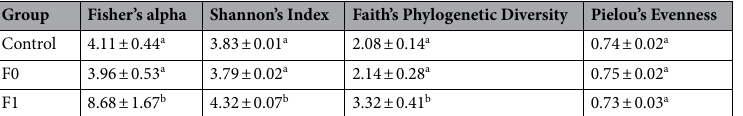
Table 2. Effect of antibiotic treatment on alpha diversity of microbial communities in C. hemipterus. Different letters in each column indicate significant differences based on Kruskal–Wallis test followed by Dunn’s Test and Benjamini–Hochberg correction ( P <